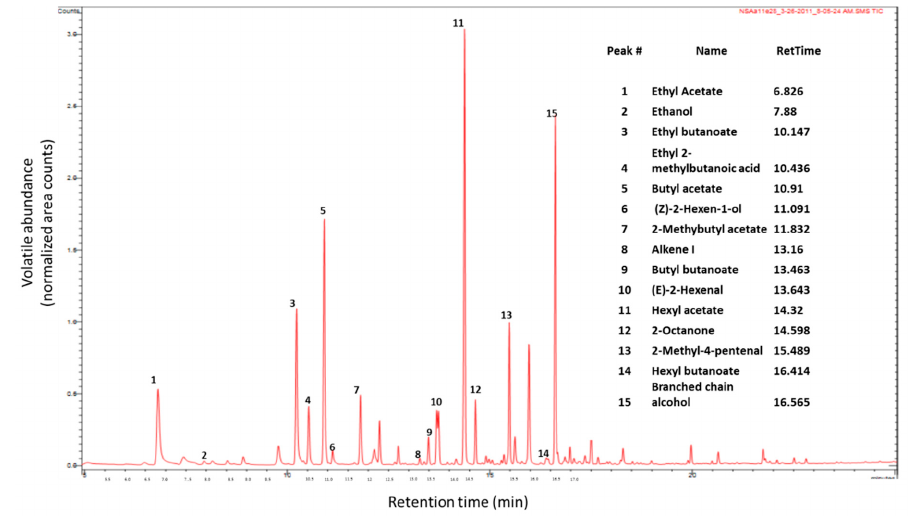
Figure 2. A typical chromatogram for cloudy apple juice from Honeycrisp apples.